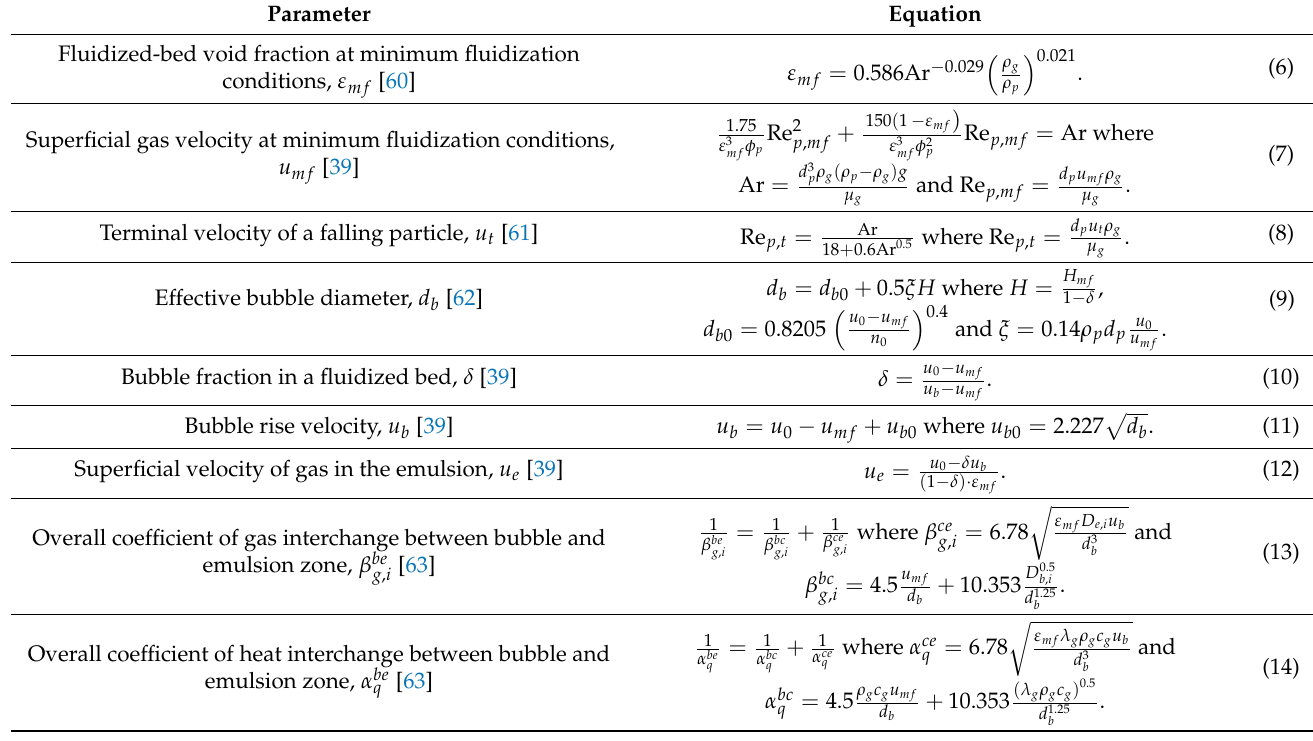
Table 2. Hydrodynamic properties and interchange coefficients in the fluidized